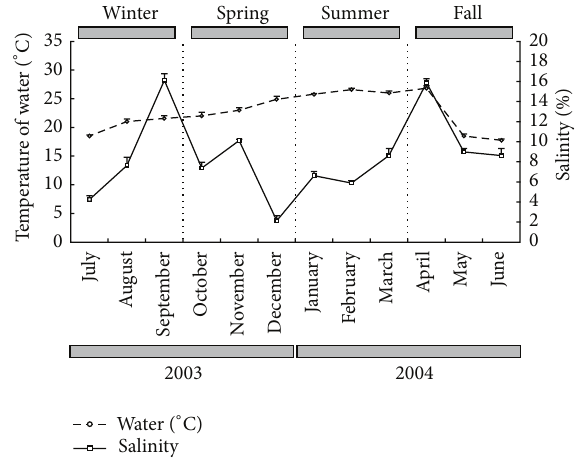
Figure 2: Mean temporal variation of salinity and temperature of bottom water, during the period from July 2003 to June 2004 (mean ± standard